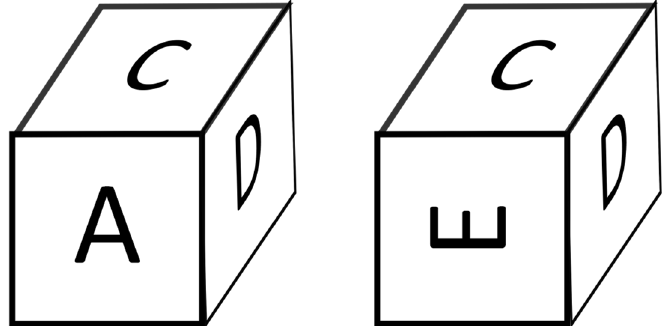
Figure A2. Example item for the Visual Search task. In this example, there are eight faces indicating sadness and one indicating disgust. The top left corner of the top left face was selected, indicating uncertainty towards whether the face displayed the majority emotion or not.